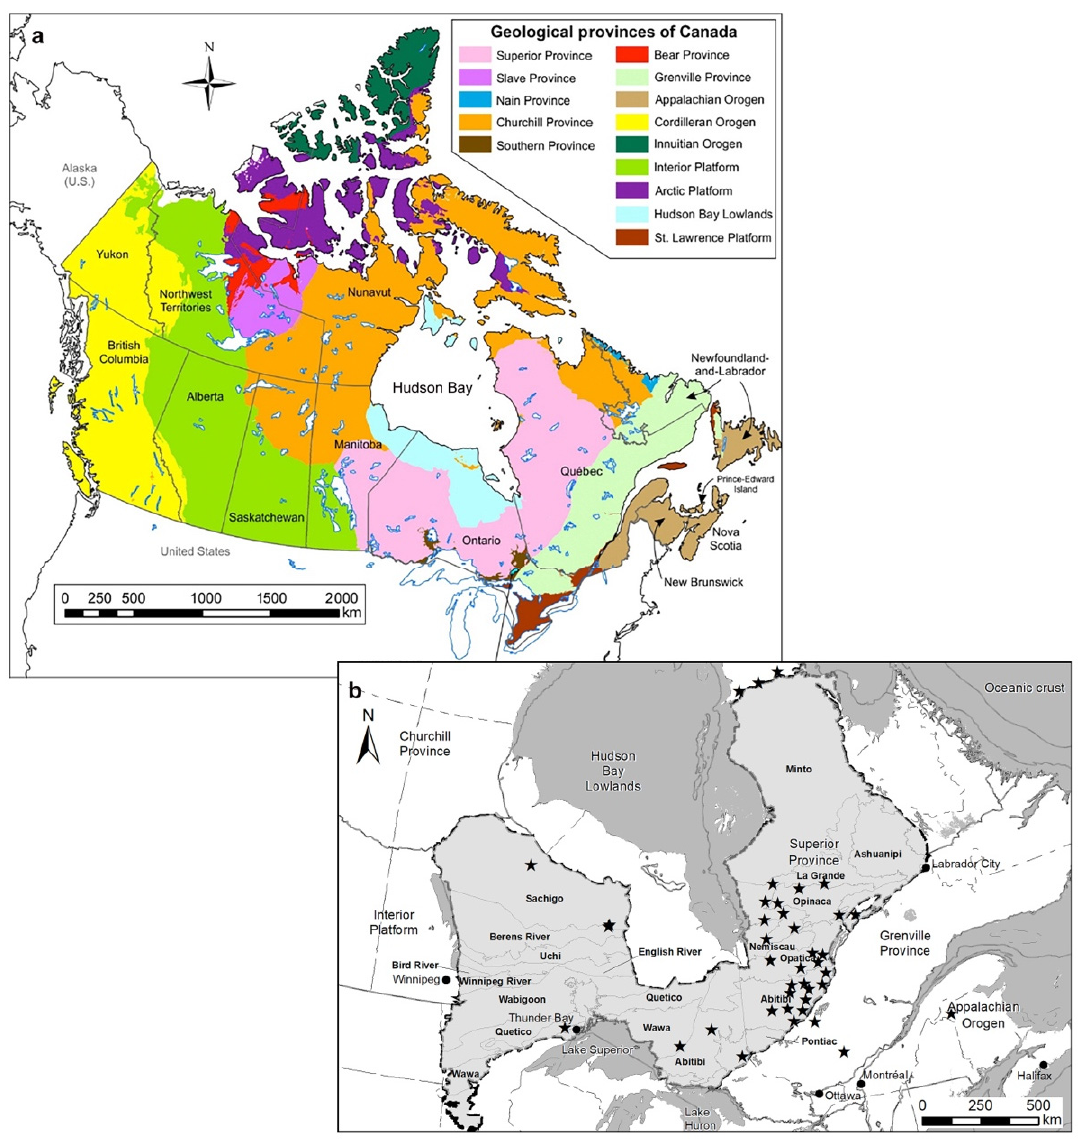
Figure 1. ( a ) Map of geological provinces of Canada (modified from Wheeler et al. [51]). ( b ) Location map of till sampling areas.